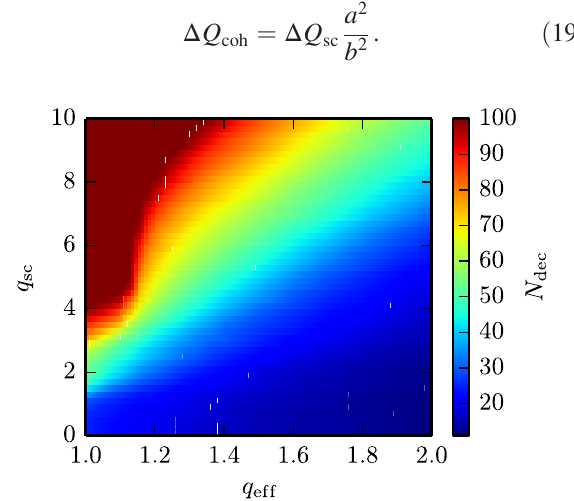
FIG. 13. The decoherence time N charge and the effective tune spread. Simulation parameters: 0 . 01 A 0 ¼ σ 0 , Q s ¼